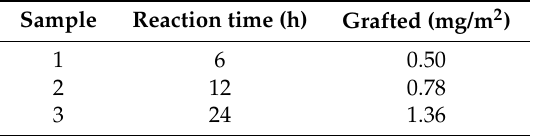
Table 2. Characterization of GAEMA grafted silica particles with reaction times from 6 to 24 h.